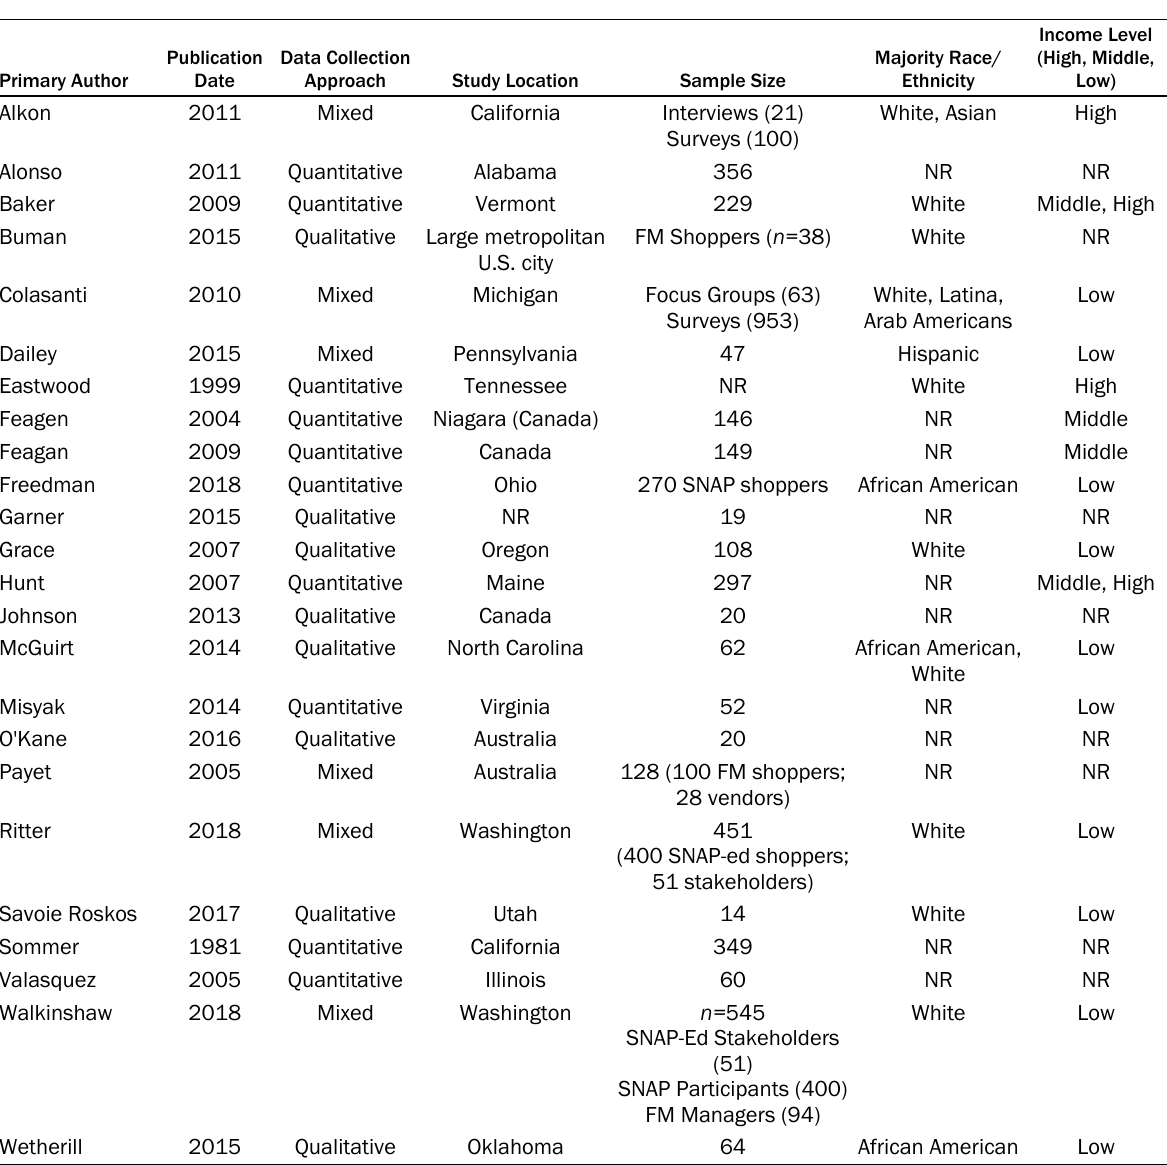
Table 2. Summary of Articles Included in the Systematic Review that Focused on Sense of Community at Farmers Markets (FM) ( n